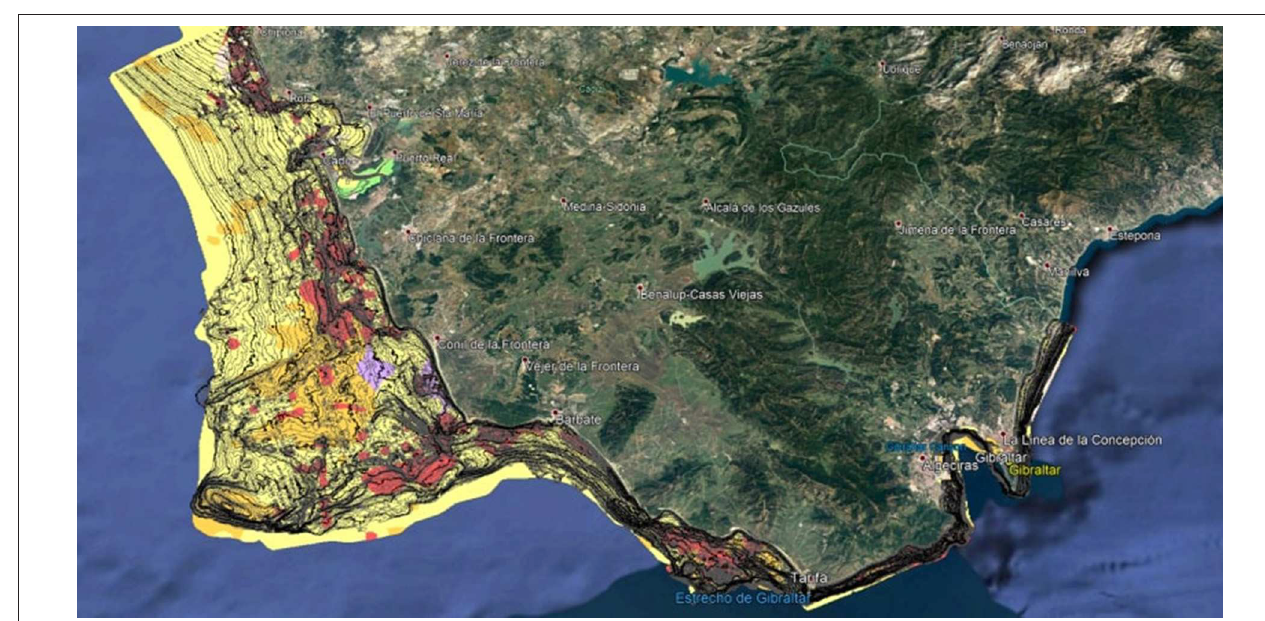
FIGURE 12 | Bathymetry and marine geomorphology along the Cadiz Coast (Spain). Map data: Google, DigitalGlobe; Data reproduced from Ecocartografias—Ecological transition Spanish Minister.